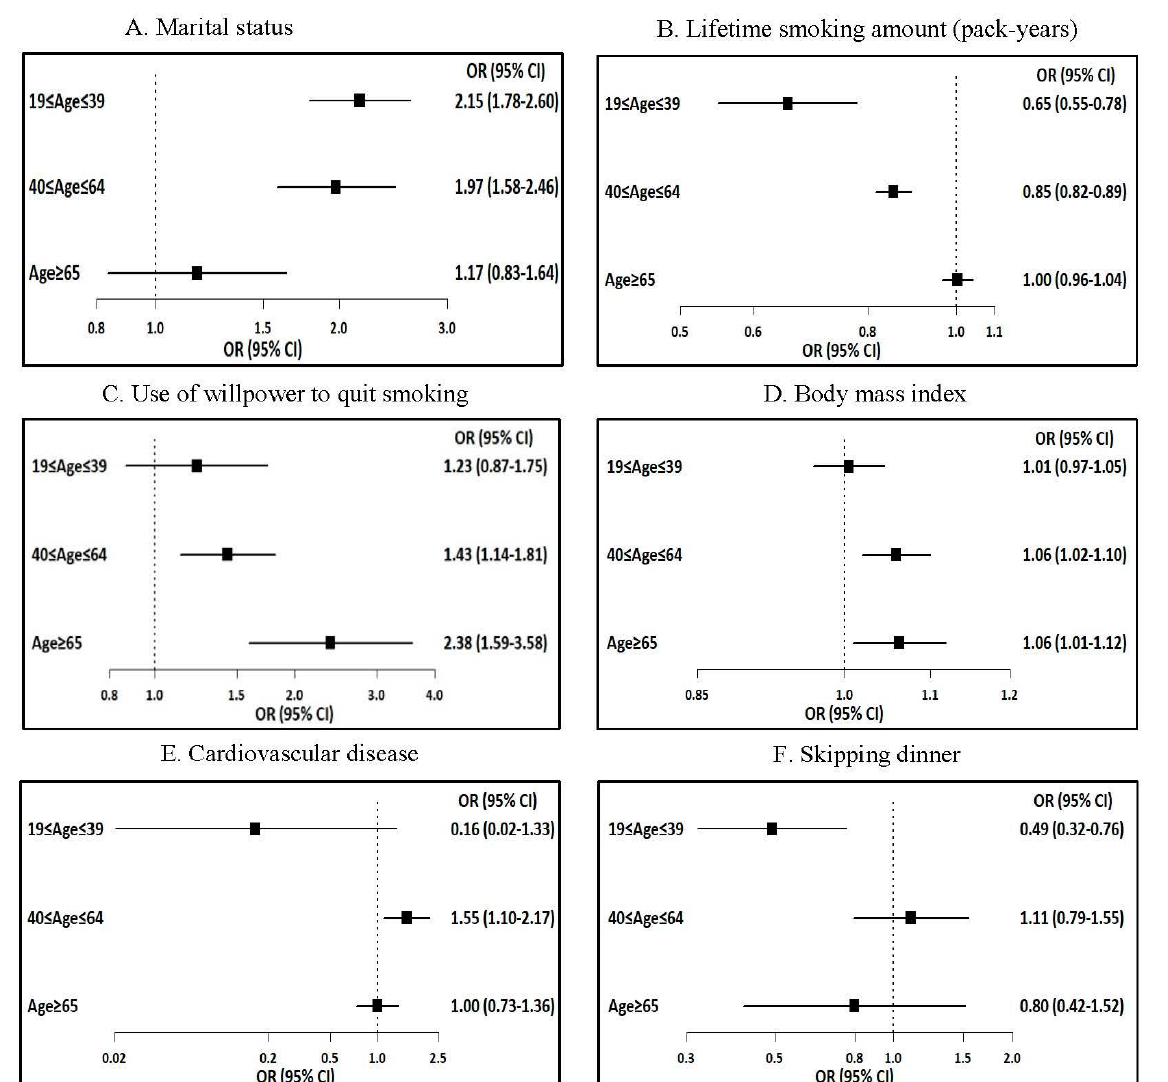
Figure 2. Factors associated with smoking cessation by age group.